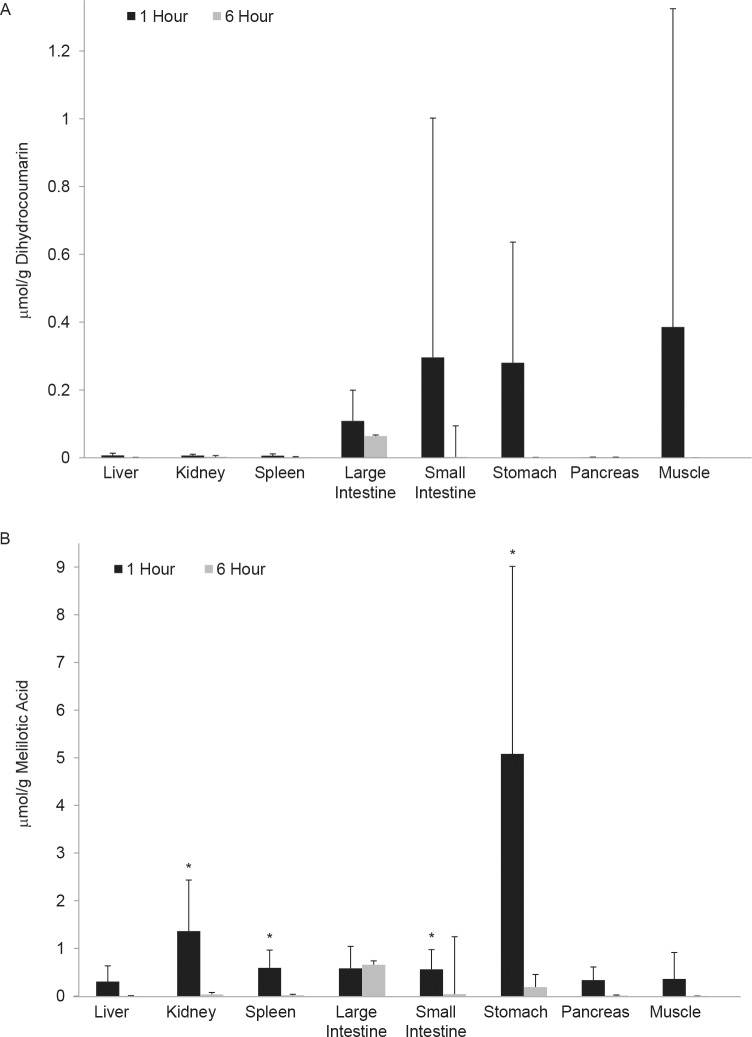
DHC and MA accumulate in digestive-tract tissues.For in vivo bioavailability analyses, rats were given 100 mg/kg DHC by gavage. DHC (a) and MA (b) were extracted from flash frozen tissues using ethyl acetate, dried, resuspended in 50% methanol, and analyzed by HPLC. The amount (μmol) of MA or DHC was quantified by determining the area under the peaks and compared to a standard curve. *Significantly more MA (b) was present at 1 hr relative to 6 hr in stomach, small intestine, spleen, and kidney, p = 0.028, 0.027, 0.026, and 0.029, respectively. AVG ± SE, n = 6. See also S3 Fig.